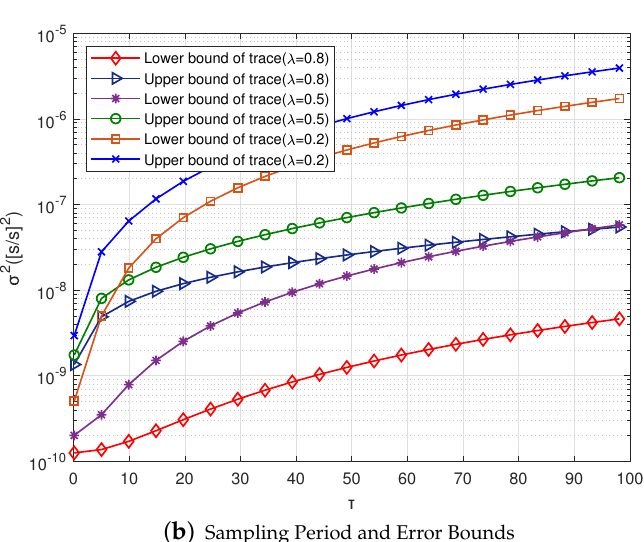
Figure 7. Relationships Between Different Factors and Error Bounds of the First-order Kalman